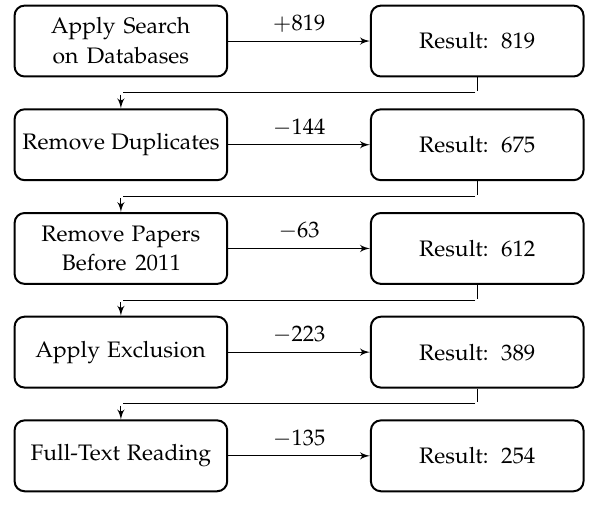
Figure 4. Mapping